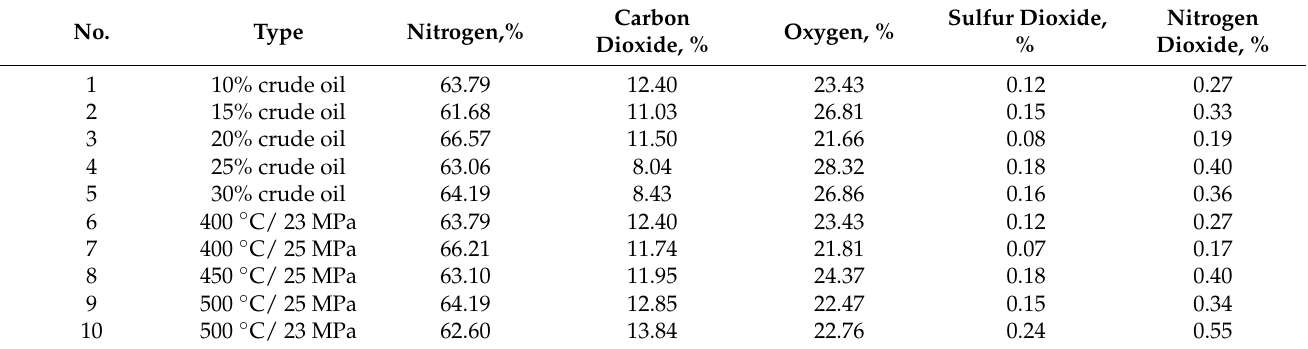
Table 8. Gas chromatographic analysis results after supercritical water–crude oil